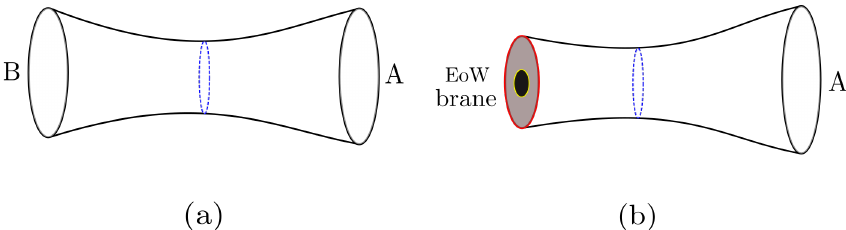
Figure 1. The inception geometry. (a) A two-boundary wormhole with asymptotic boundaries A and B . The blue dotted circle denotes the bifurcate horizon. (b) The side B is truncated and replaced by an EoW brane (red circle). The gray region is the inception disk containing the inception black hole (black) with its inception horizon (yellow